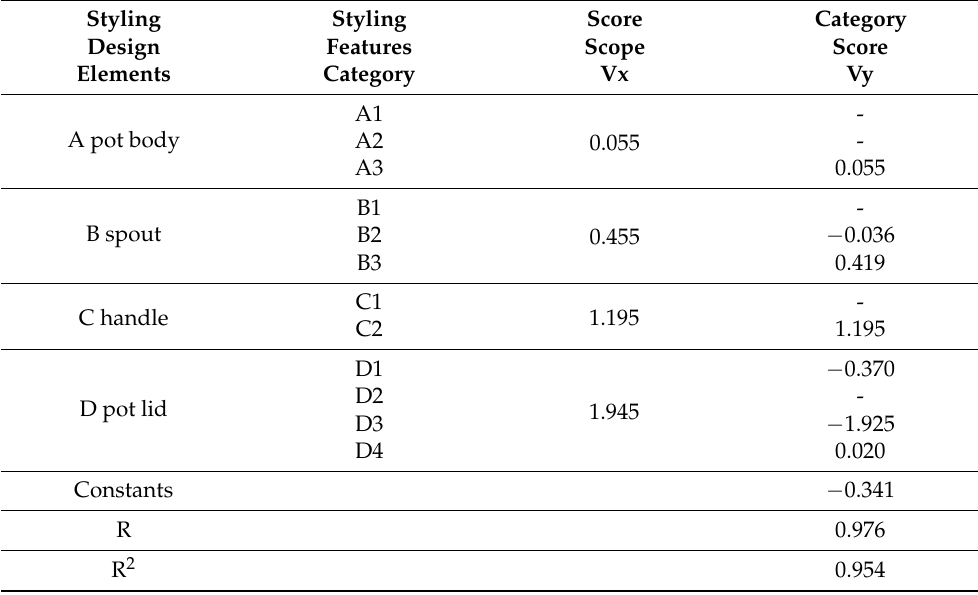
Table 9. Results of the analysis of the temperament factor